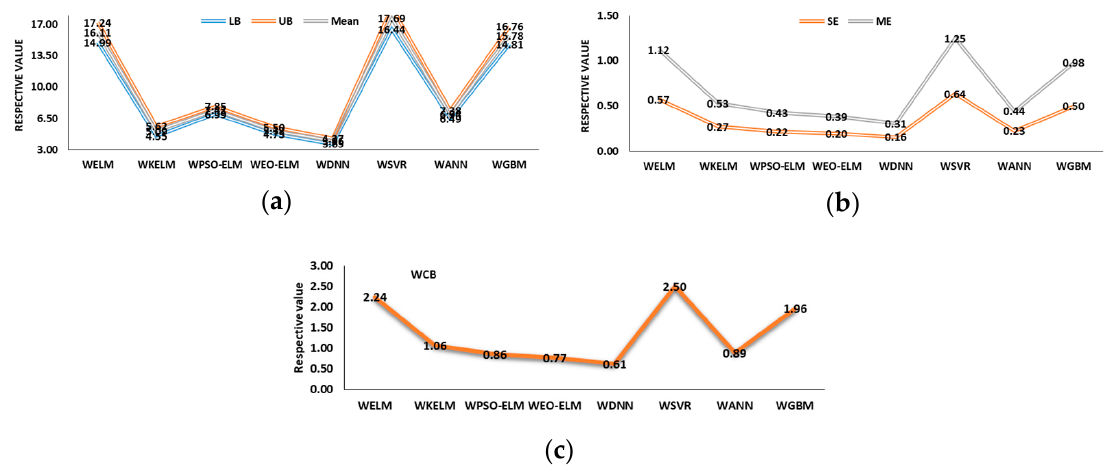
Figure 23. Visual representation of UA for wavelet-based models (Teifi at Glanteifi), ( a ) LB, UB and Mean; ( b ) SE and ME; ( c ) WCB.